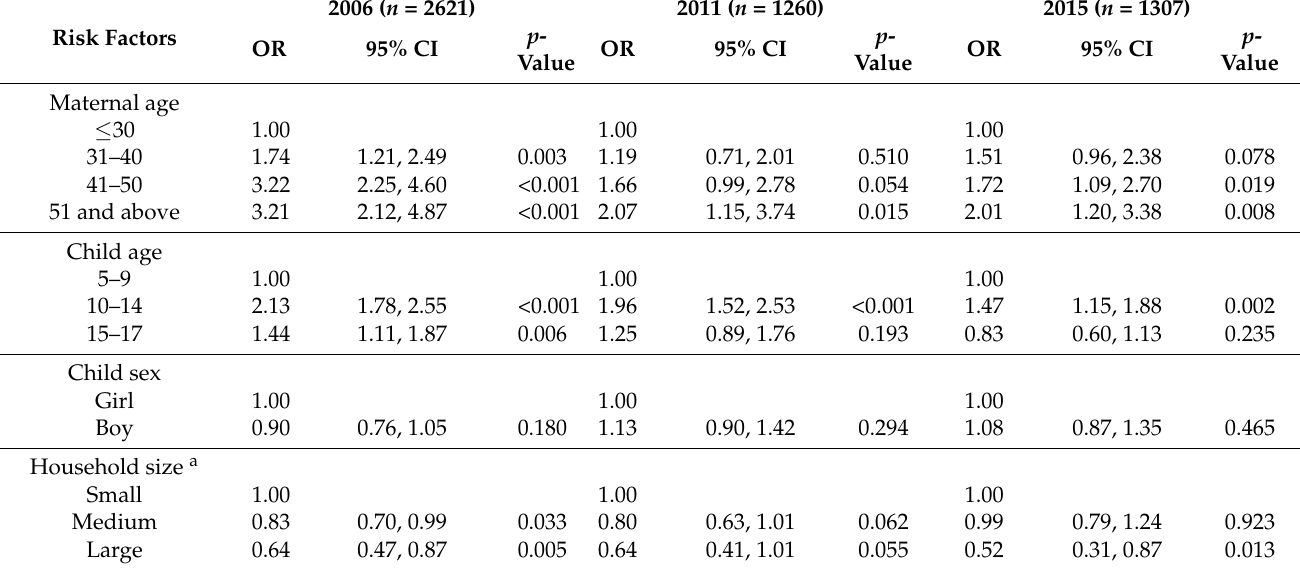
Simple logistic regression model for the factors associated with overweight mother/overweight child pairs in Malaysia for 2006, 2011 and